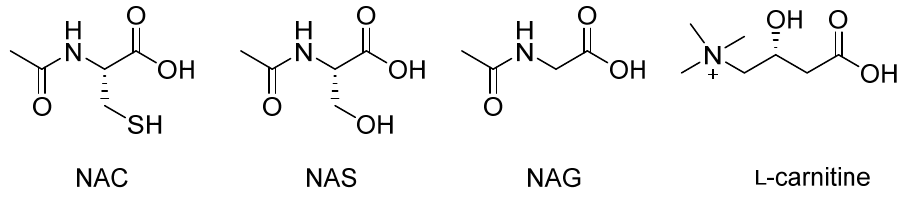
Figure 5. Aminoacids acting as non-inhibitory PCs.